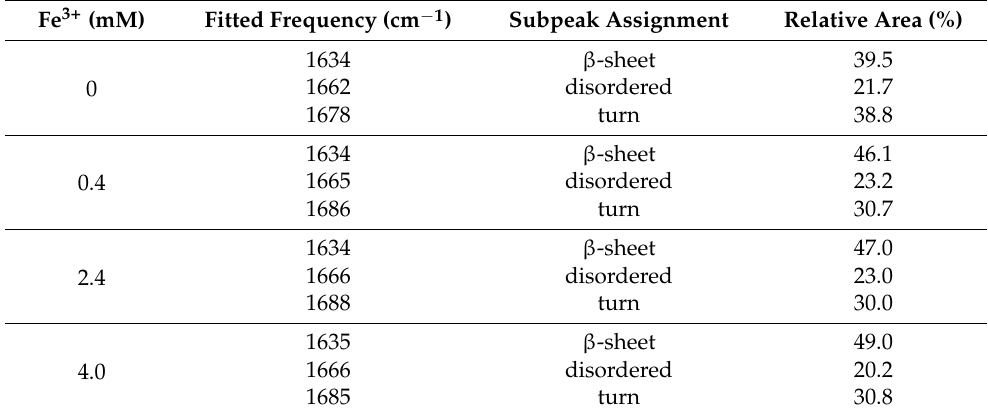
Figure 1. FTIR spectra of α -synuclein amyloid fibril under the influences of different concentrations of Fe 3+ and curve-fitting results in the amide I region. ( a ) control; ( b ) 0.4 mM; ( c ) 2.4 mM; ( d ) 4.0 mM; solid black line: measured spectrum; dash red line: overall fit; solid blue line: fitted subpeak. a.u.: arbitrary unit. Table 1. Curve-fitting results of the FTIR spectra of α -synuclein amyloid fibril under the influence of different concentrations of Fe 3+